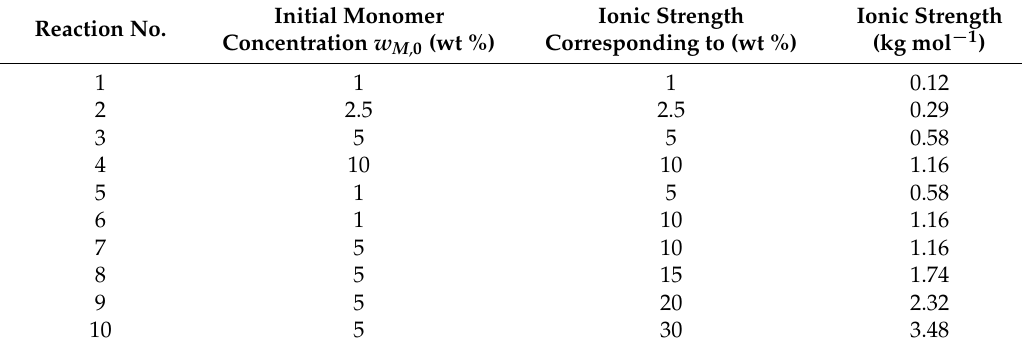
Table 4. List of all polymerization reactions of fully ionized MAA (alpha = 1) in aqueous solution at 50 ◦ C and 0.1 wt % of 2,2 (cid:48) -azobis(2-methylpropionamidine) dihydrochloride (V-50) initiator. Reaction No.